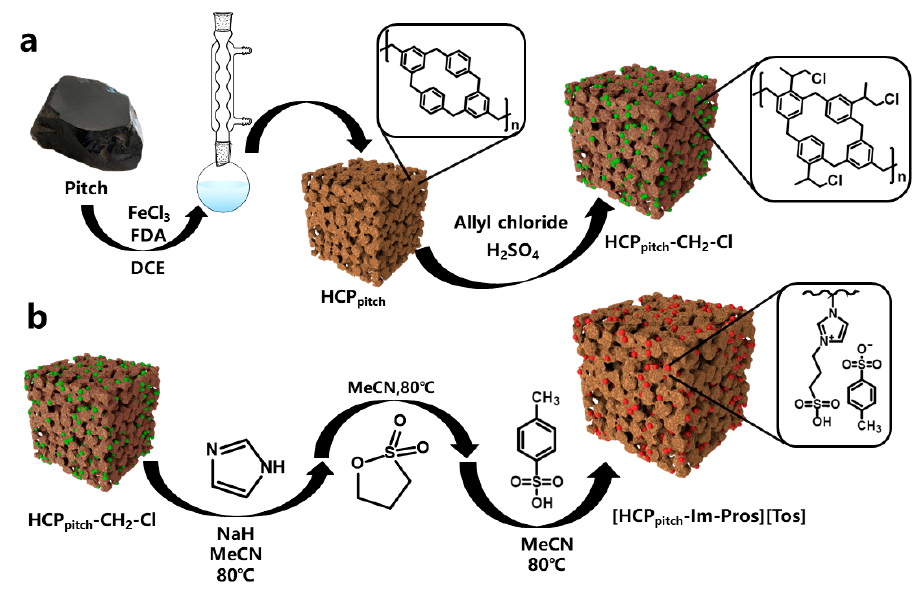
Figure 1. Schematic illustration of the synthesis of ( a ) HCP pitch –CH 2 –Cl and ( b ) [HCP pitch –Im–Pros][ Tos] catalyst.